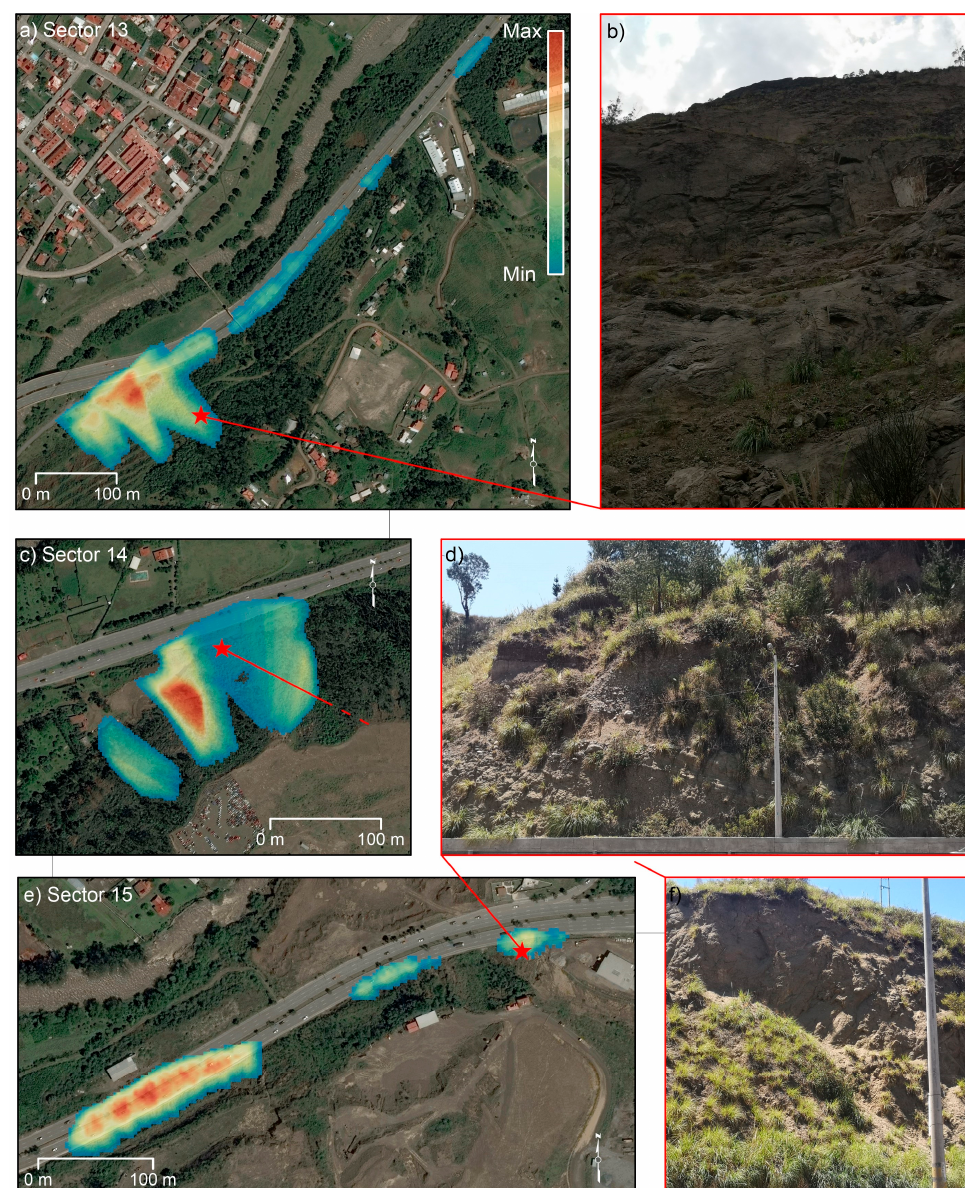
Figure 11. Outcomes of QPROTO algorithm for sector n° 13 ( a ), 14 ( c ), and 15 ( e ) with different classes of potential rockfall runout occurrences; the pictures ( b ), ( d ), and ( f ) show the slopes prone to collapse for sector numbers 13, 14, and 15, respectively.